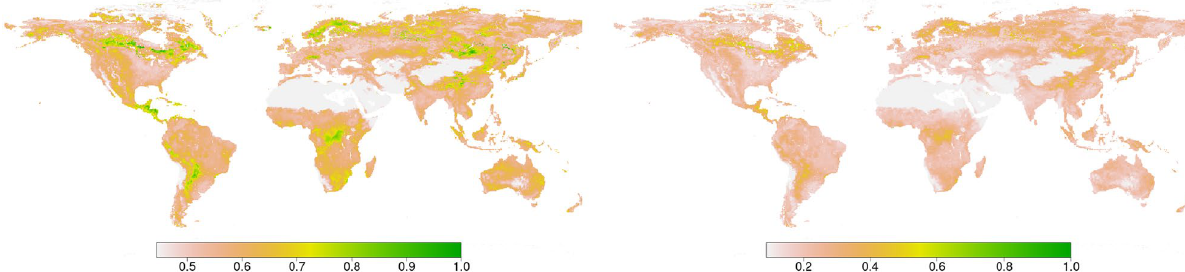
Figure 7. Pearson’s and Spearman’s correlation by pixel between root and surface moisture for the 11 year period used. The figure was generated using R version 3.6.1 (https:// www.r- proje ct. org/) using the raster package version 3.0-7 (https:// cran.r- proje ct. org/ web/ packa ges/ raster/ raster.